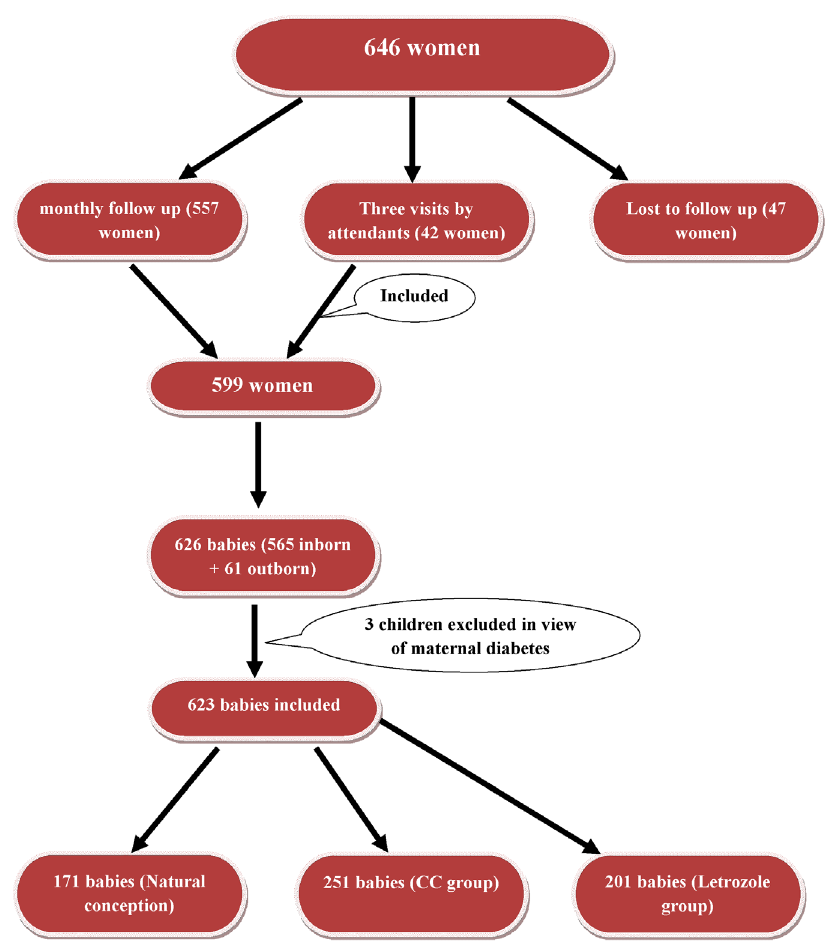
Figure 1. Flowchart showing the women and children included in the study. doi:10.1371/journal.pone.0108219.g001 as shown in Table 2. The mean birth weight of babies was comparable in natural conception group and letrozole group.